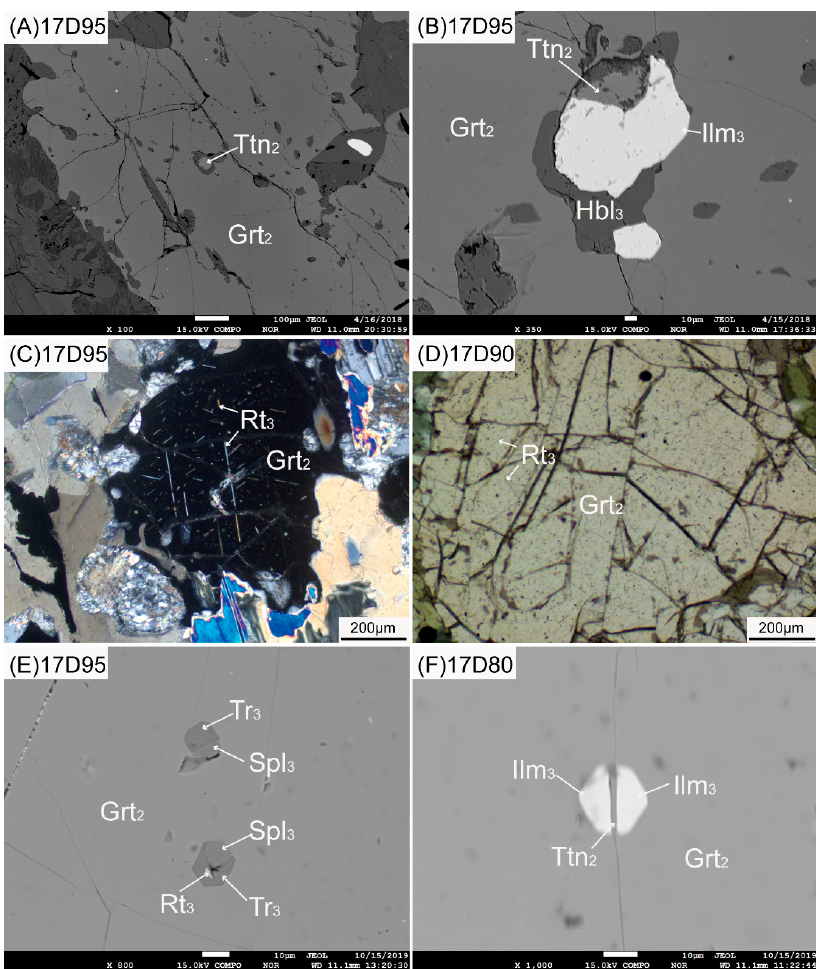
Figure 3. Micropetrographic evidence of ultra-high pressure (UHP) metamorphism. ( A ) High-Al titanite enclosed in garnet porphyroblast. ( B ) High-Al titanite rimmed by ilmenite and hornblende within garnet porphyroblast. ( C,D ) At least three groups of rutile lamellae (the needles) exsolved from within the garnet. ( E ) Idiomorphic multiple-phase inclusion of spinel (Spl) + tremolite (Tr) ± rutile (Rt) within garnet. ( F ) Idiomorphic hexagon ilmenite separated by high-Al titanite from centerline in garnet.